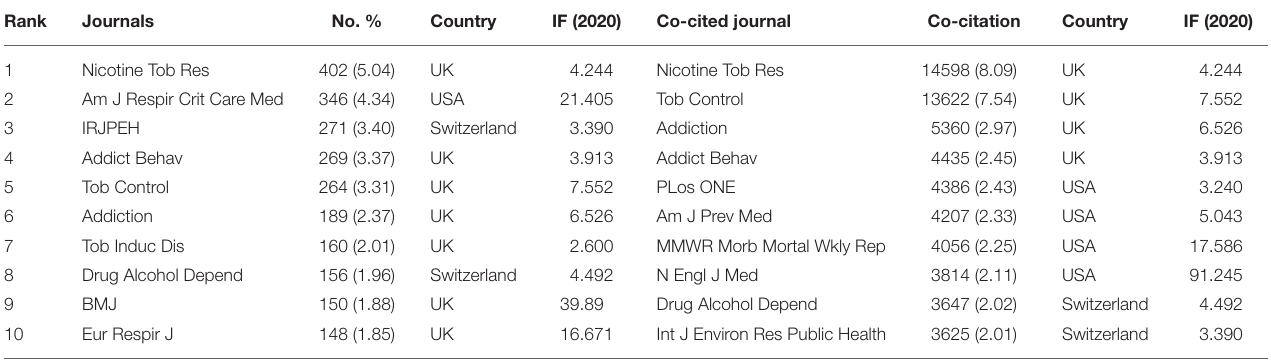
TABLE 2 | Top ten journals and co-cited journals of e-cigarettes research. Rank Journals No. %